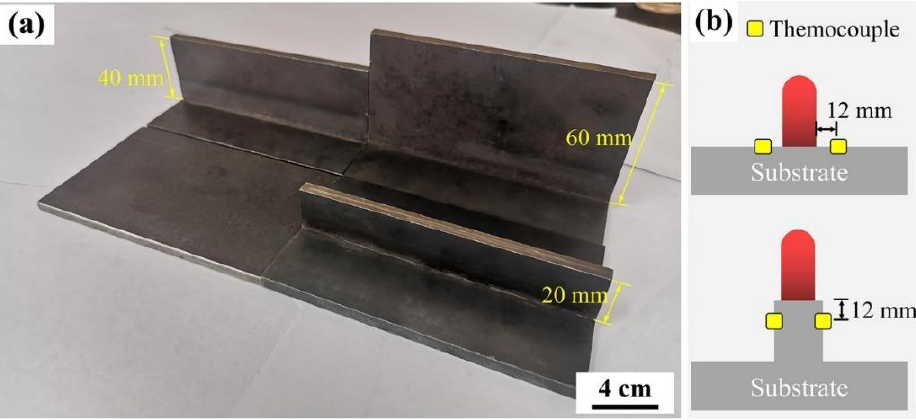
Figure 3. ( a ) The T-beam substrates; ( b ) Location of